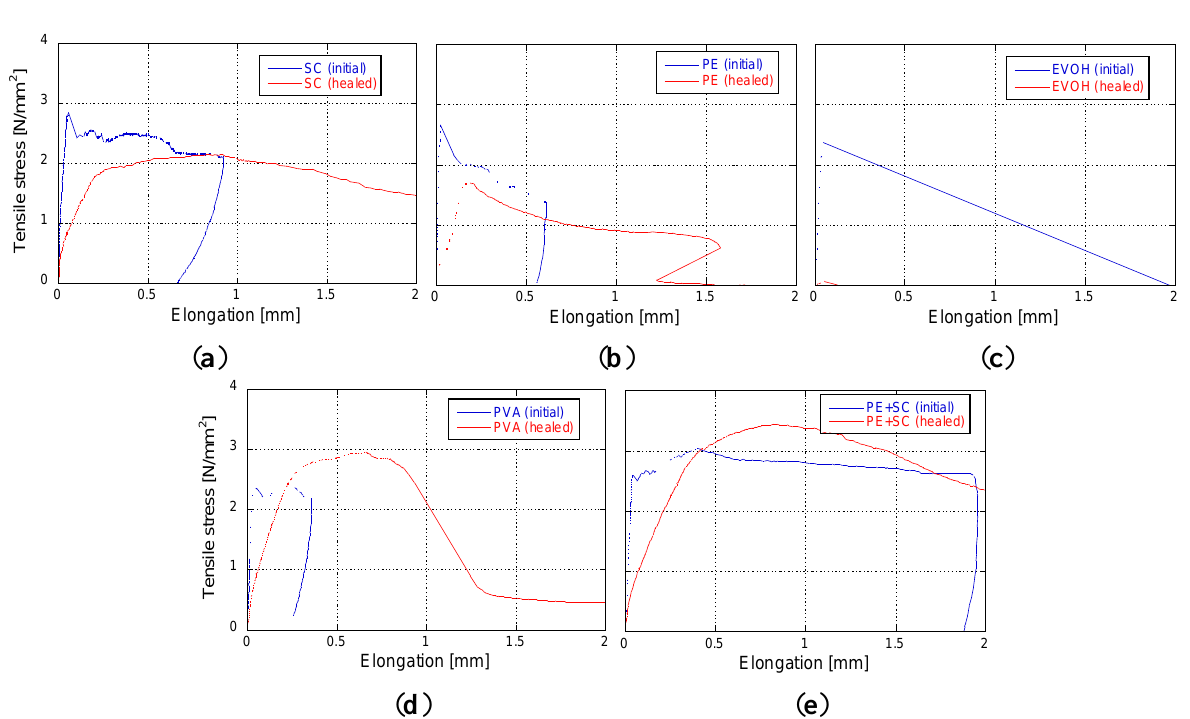
Figure 9. Typical examples of relationship between elongation and tensile stress: